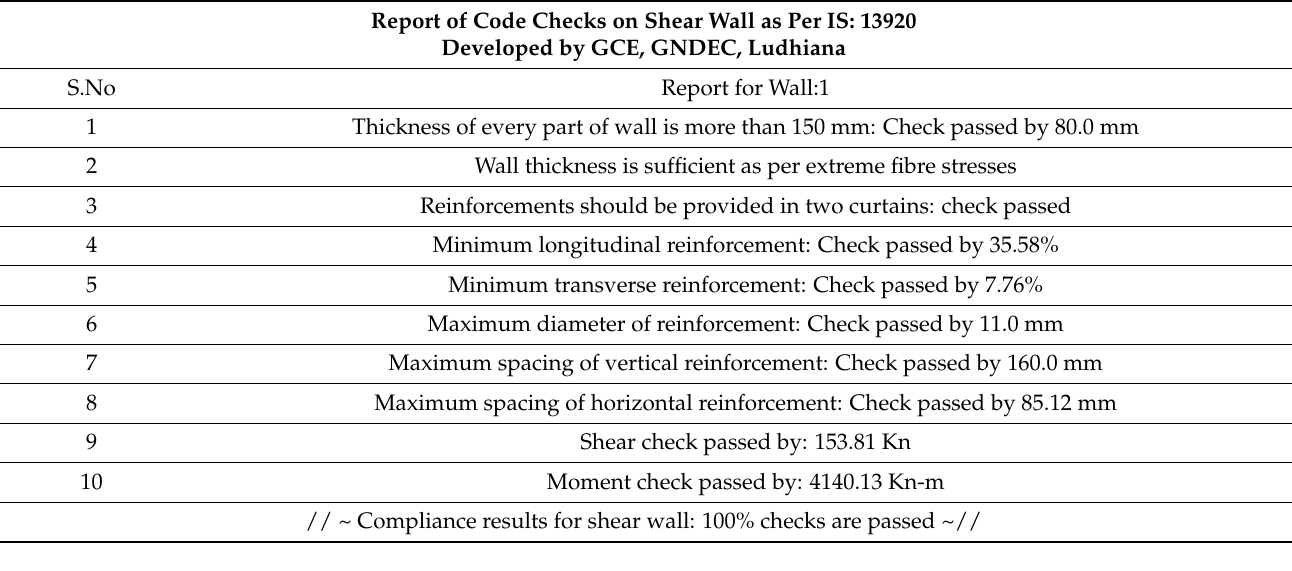
Table 6. Report File Generated for Shear Wall 1.